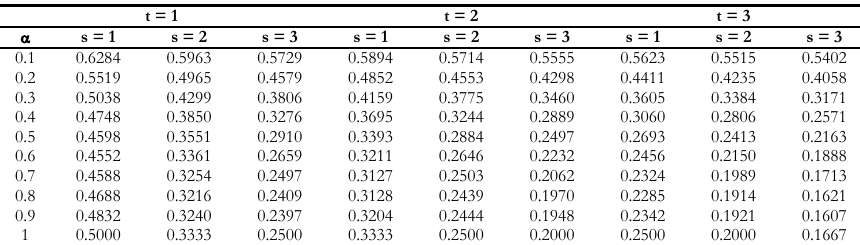
count model for different values of the parameter  at t = 1,2,3 and s = 1,2,3 t =